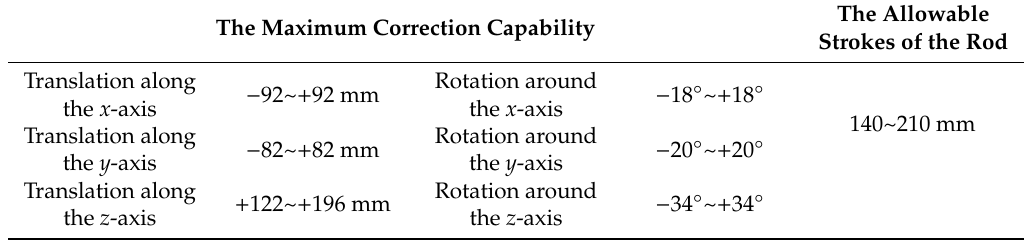
Table 1. The maximum correction capability in space-reachable